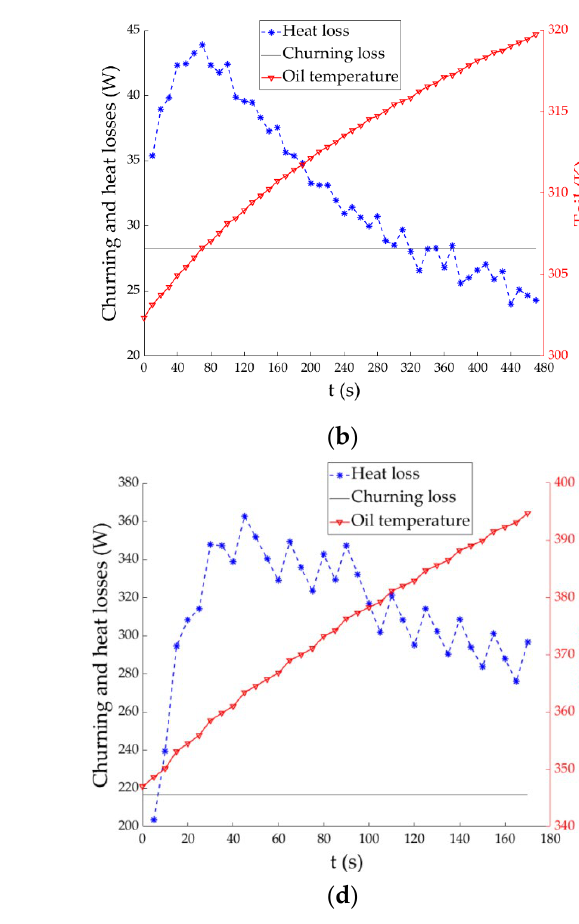
Figure 15. The transmission heat loss simulation results with experimental T oil compared with the reference churning loss: ( a ) at 1000 rpm; ( b ) at 2000 rpm; ( c ) at 4000 rpm; ( d ) at 6000 rpm. Table 4. Deviations of simulation values to reference values at different